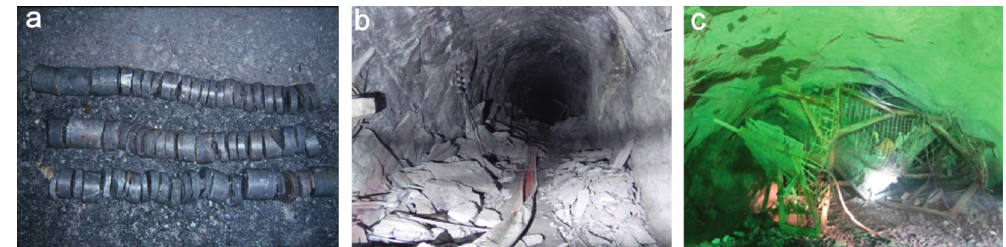
Figure 7: The high stress phenomena in the underground powerhouse: (a) the irregular lamps cake core, (b) rock mass splitting and spalling occurring at the 2nd-layer drainage gallery, and (c) roof collapse induced by rock burst in No. 2 tailrace tunnel in the underground powerhouse.